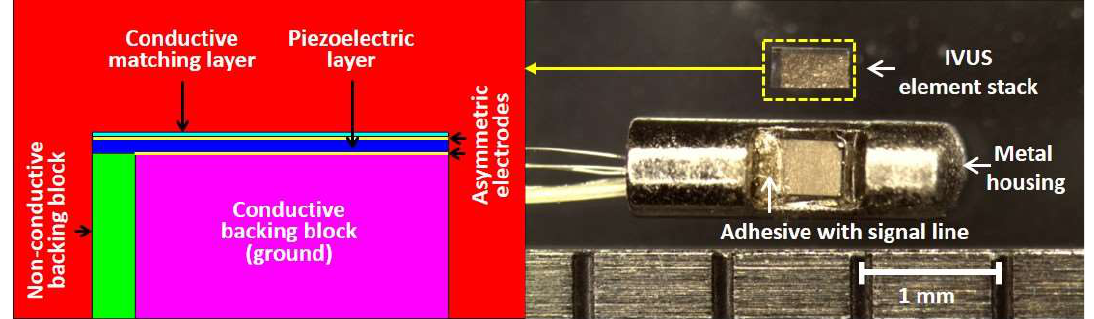
Figure 8. Schematic diagram and photograph of the prototype intravascular ultrasound (IVUS) transducer with the proposed technique: ( left ) Schematic diagram of the IVUS element stack; and ( right ) photograph of the (top) fabricated IVUS element stack with side view; and (bottom) fully fabricated IVUS transducer at proximal portion before combining a needle type brass tube.